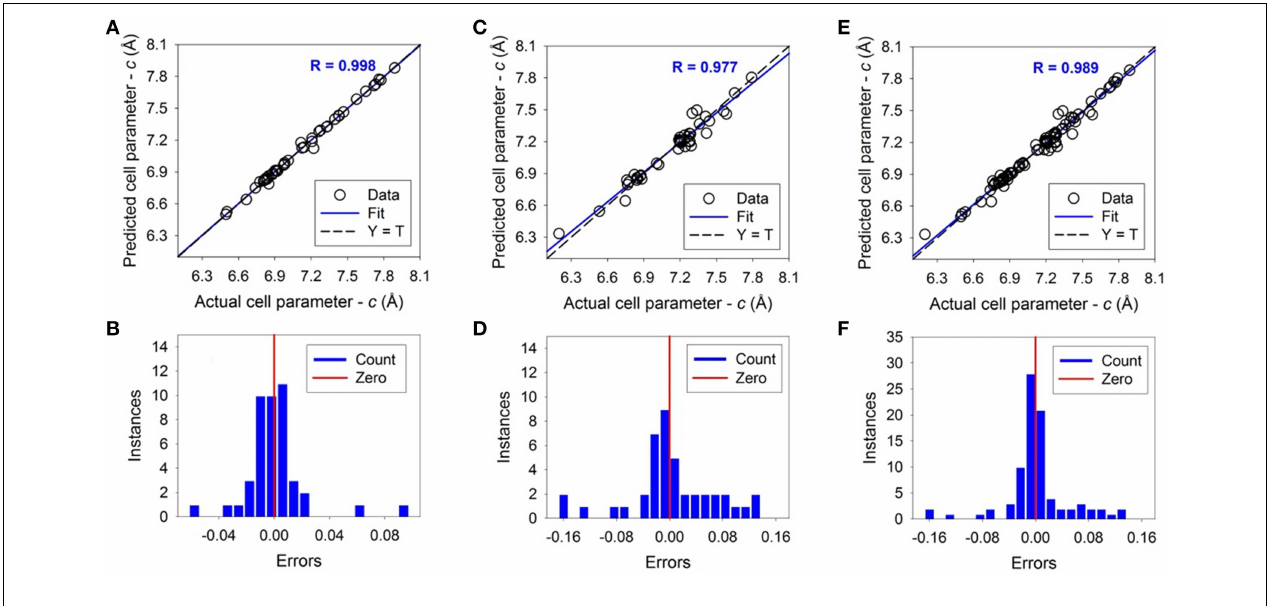
FIGURE 4 | The results of Artificial Neural Network simulations of unit cell parameter c . The upper figures show the correlations between predicted and actual values. The bottom figures show the error distributions around the vertical red bars of zero error. The dashed lines